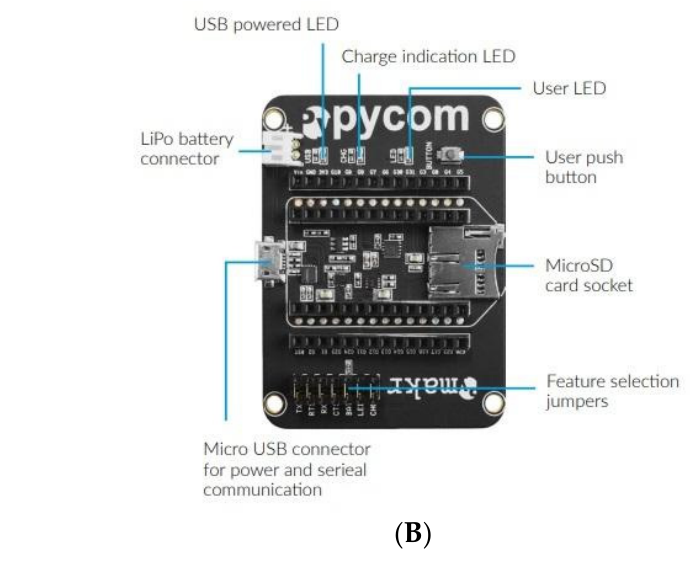
Figure 17. ( A ) LoPy4 model ( B ) Pycom Expansion Board 3.0.